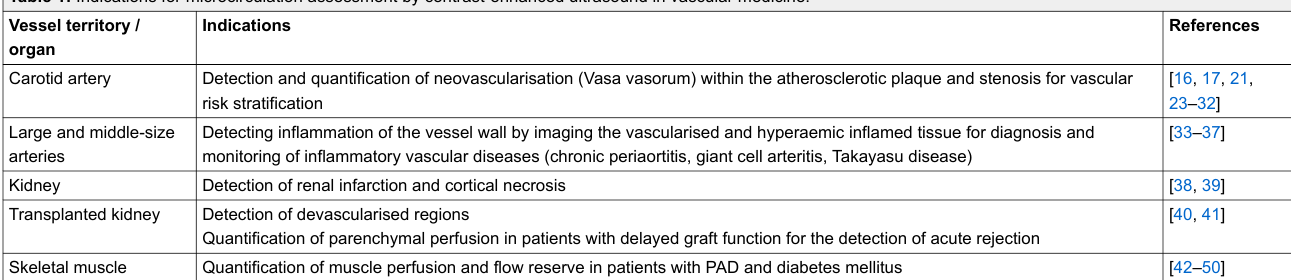
Table 1: Indications for microcirculation assessment by contrast-enhanced ultrasound in vascular medicine. Vessel territory / Indications organ